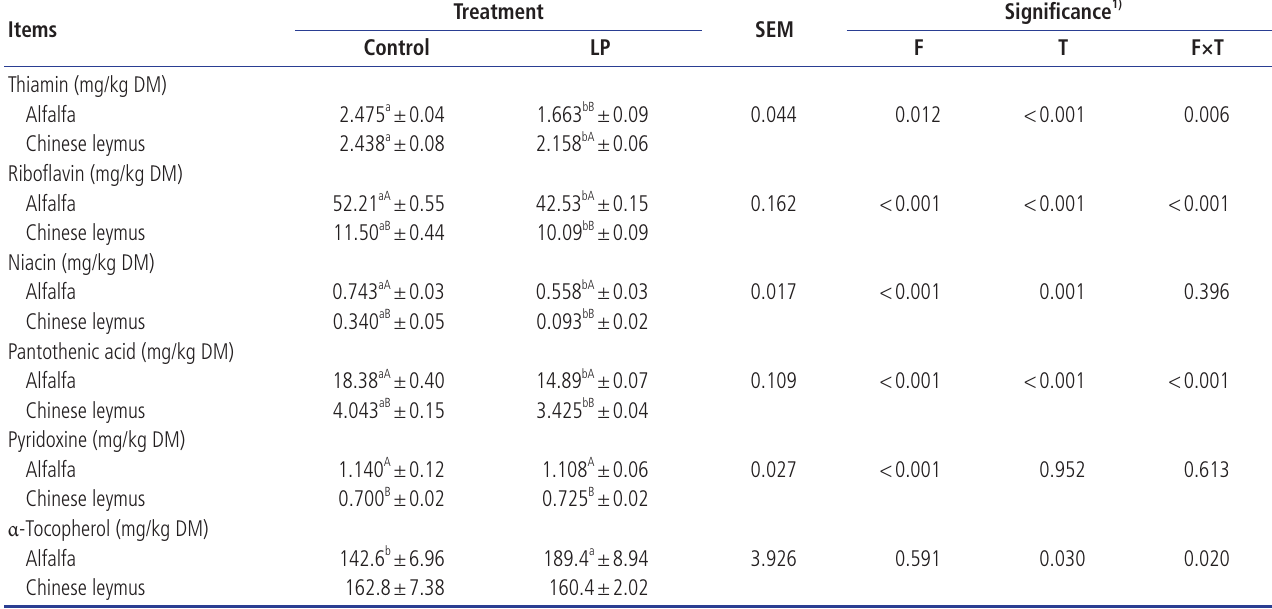
Table 4. Vitamin concentrations of alfalfa and Chinese leymus